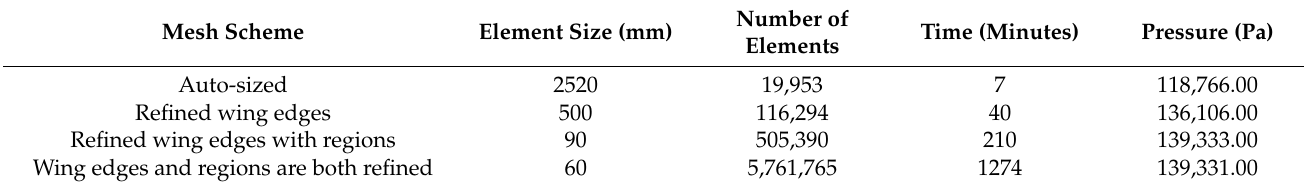
Table 5. Results of the Mesh Independence Study in 3D Winglet Analysis.